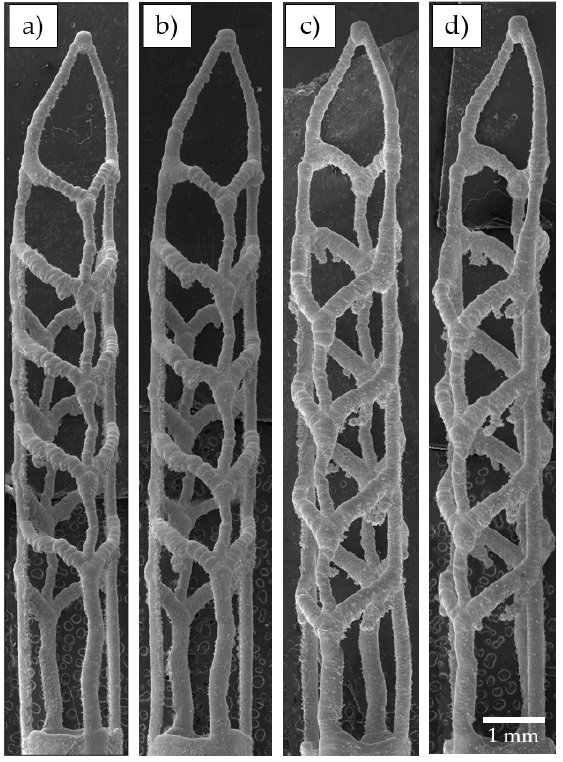
Figure 10. 3D-printed SAF samples fabricated with various regimes: ( a ) P100V850, ( b ) P150V1100, ( c ) P100V400, ( d ) P50V200.